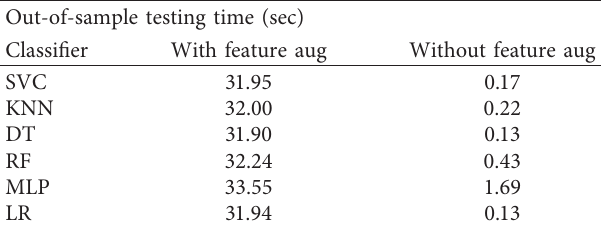
Table 8: Time measurements of out-of-sample testing. Out-of-sample testing time